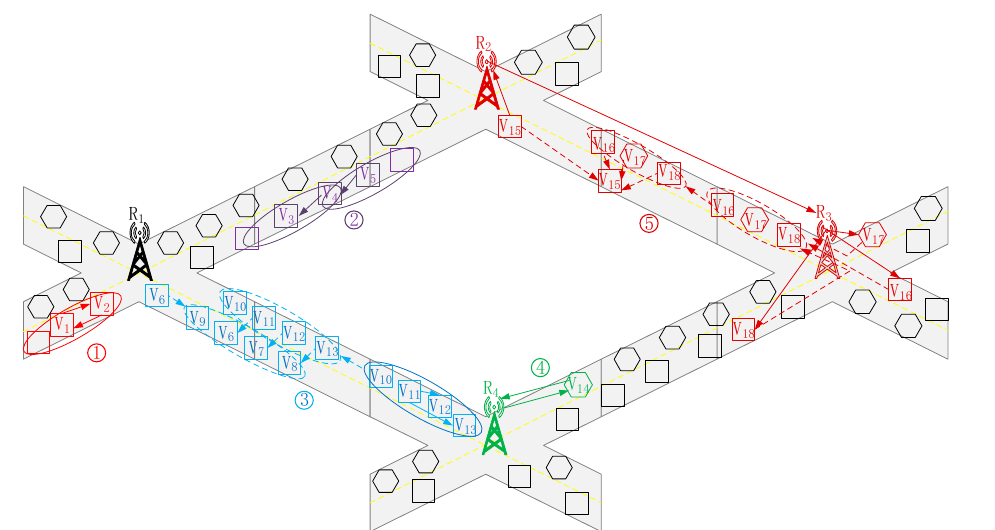
Figure 2. The flowchart of content acquisition.